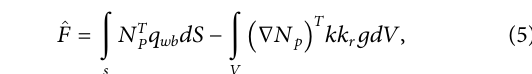
Frontiers in Earth Science |